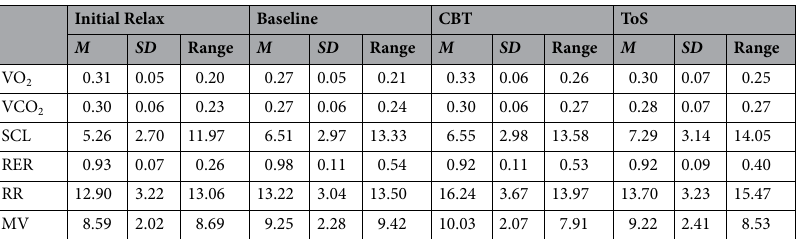
Table 1. Descriptive statistics of the psychophysiological measurements across experimental conditions. SCL = Skin conductance level (µS), VO 2 = Volume of oxygen uptake (l/min), VCO 2 = Volume of carbon dioxide (N = 25).